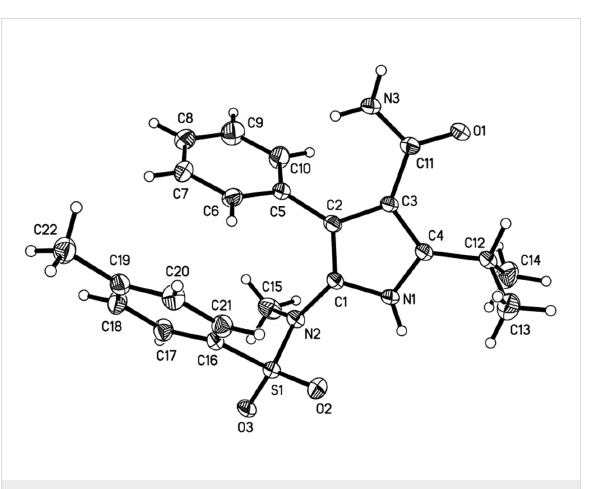
Figure 4: Molecular structure in the solid state of compound 10ad .